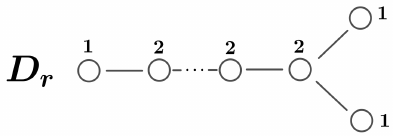
Figure 6 . Dual Coxeter labels for the D series.